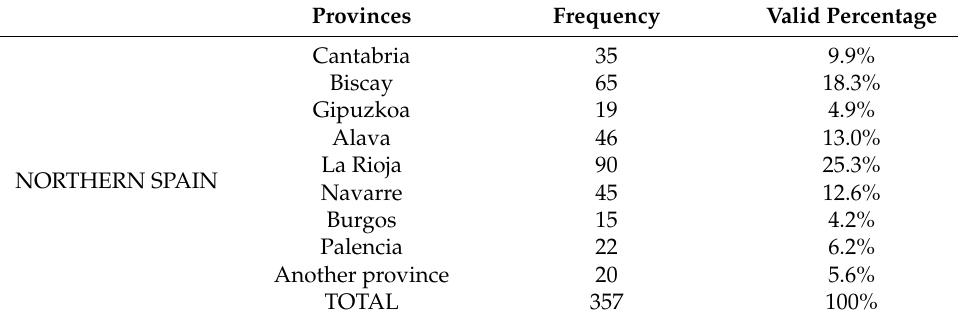
Table 1. Target sample of the study. Grandparents of children in primary education (6 – 12 years) in northern Spain.